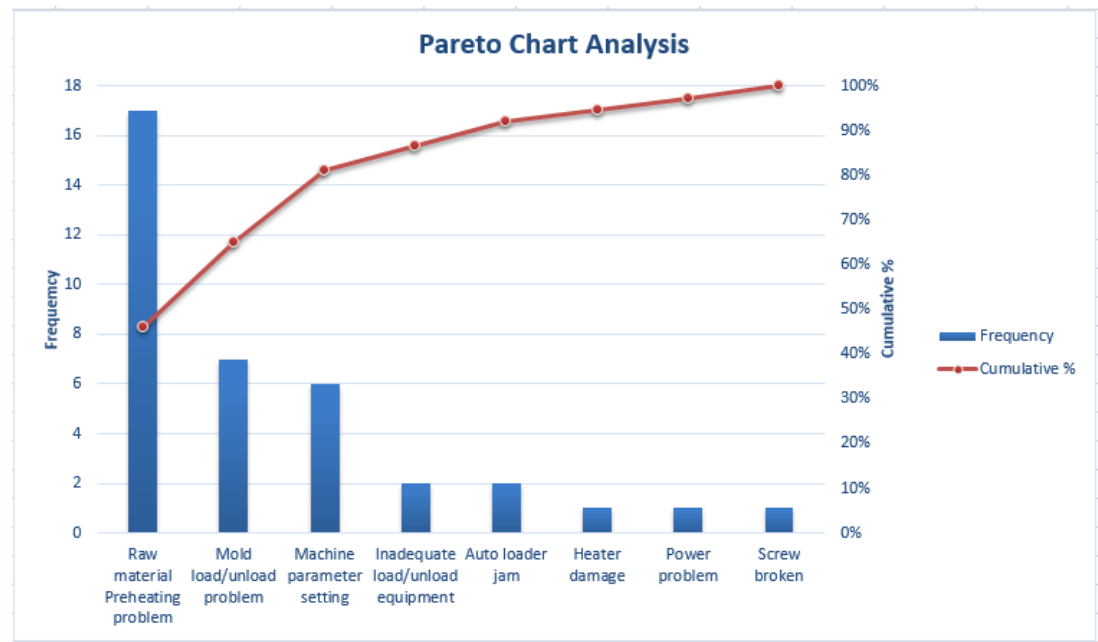
Figure 2. Pareto chart